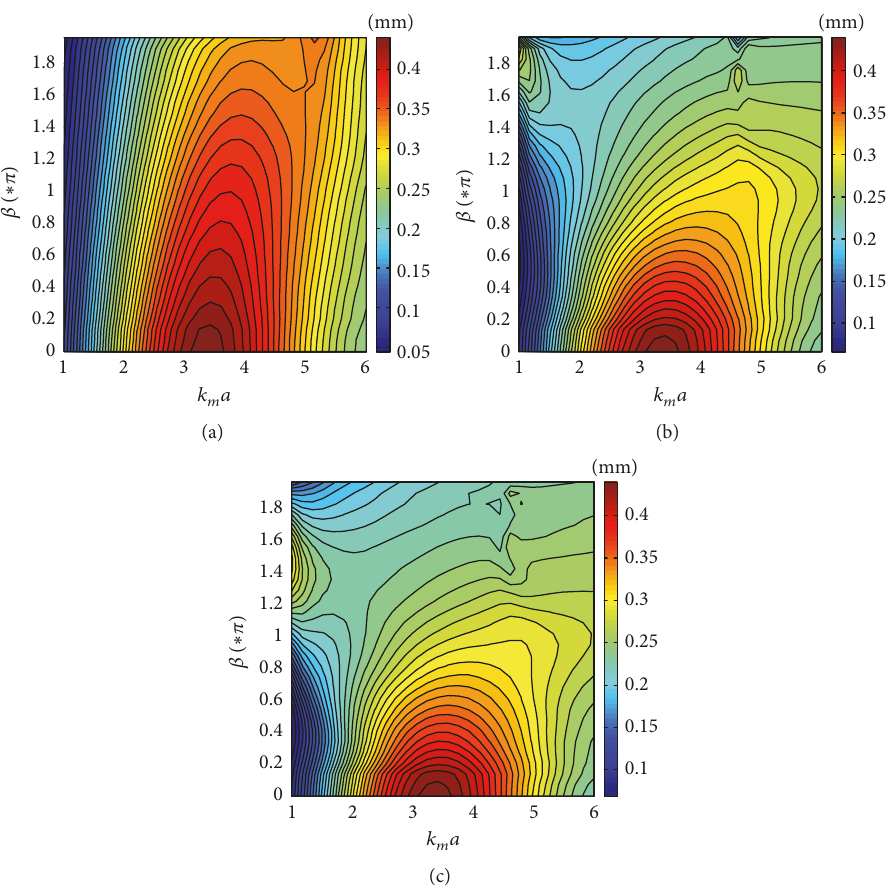
Figure 8: Contour plots of ⟨𝜎 𝑠 ⟩ changing with 𝑘 𝑚 𝑎 and 𝛽 at (a) 𝐾/𝐾 𝑝 = 0.1 , (b) 𝐾/𝐾 𝑝 = 0.01 , and (c) 𝐾/𝐾 𝑝 = 0.001 .